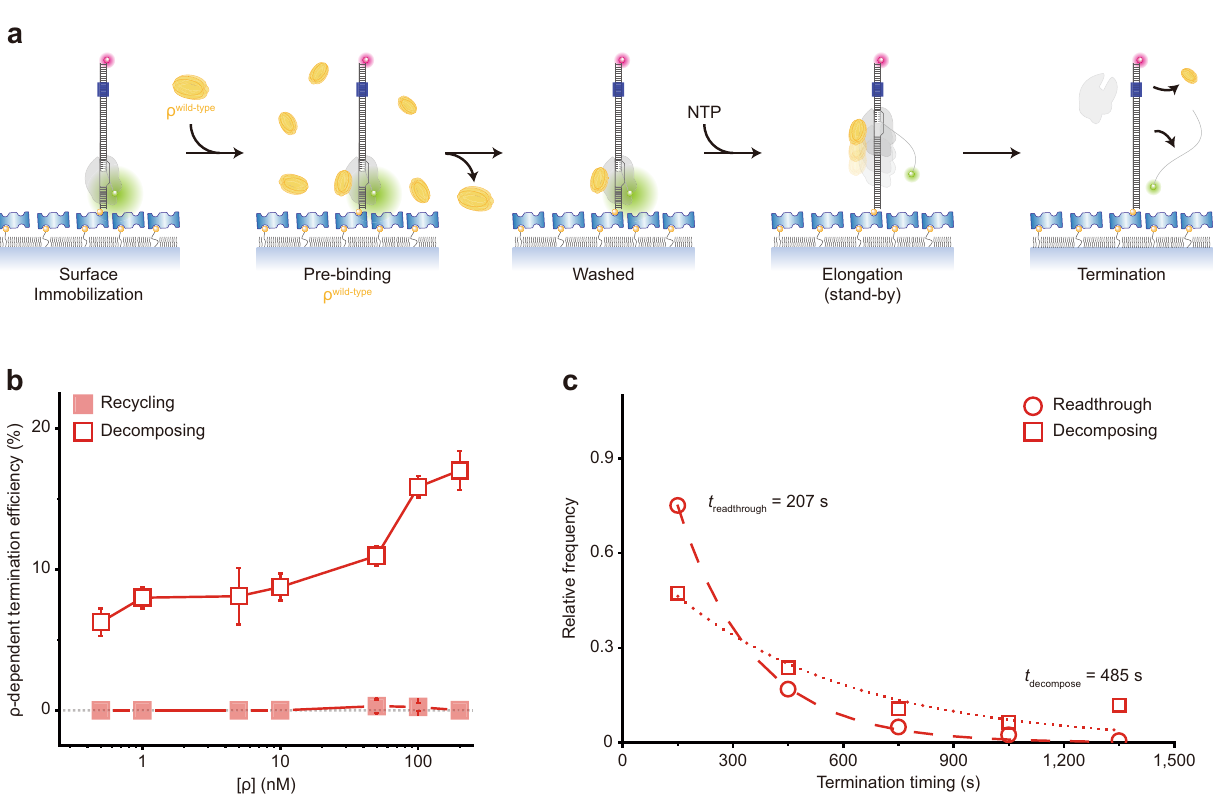
Fig. 2 Stand-by ρ mediating only decomposing but not recycling termination. a Scheme for the stand-by single-molecule assay. Termination is mediated only by the stand-by ρ pre-bound on RNAP in the absence of catch-up ρ . b ρ -dependency of stand-by decomposing termination. The ρ -dependent TEs of decomposing (open) and recycling (solid) in the y -axis are plotted against ρ concentrations on a base-10 log scale in the x -axis. Recycling is virtually null over the entire range of ρ concentrations used, so the decomposing data overlap with their sum data (not shown). c Relative frequencies of readthrough ( n = 326 complexes) and decomposing ( n = 93) timings measured in stand-by assays. The data are fi tted to single exponential functions. Error bar represents the standard deviation of the mean from n ≥ 3 independent experiments. The numbers of analyzed molecules for ( b ) are in Supplementary Table 2. Source Data fi le includes the data for ( b , c